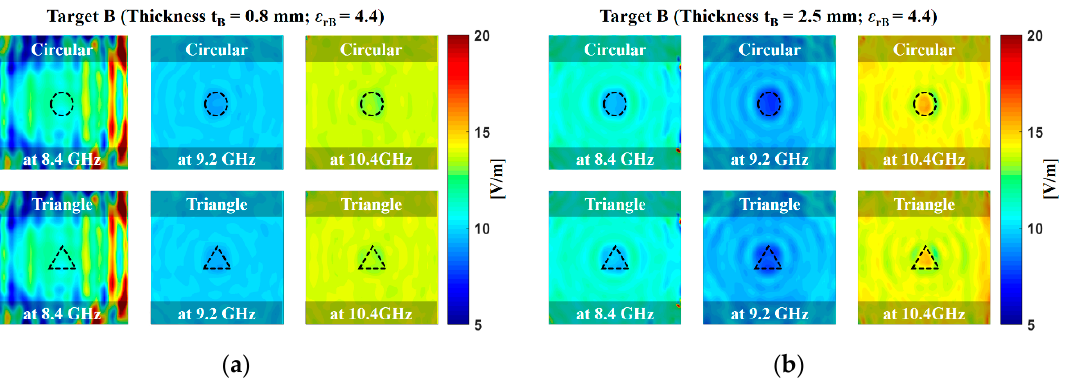
Figure 7. Measured microwave image of target B with the thicknesses of ( a ) 0.8 mm and ( b ) 2.5 mm at scanning frequencies of 8.4 GHz, 9.2 GHz, and 10.4 GHz. Target B was a woven fiberglass cloth and epoxy resin binder with the dielectric constant ( ε rB ) of 4.4. A total of 2601 frequency sampling points were extracted by using HP 8510C VNAs.